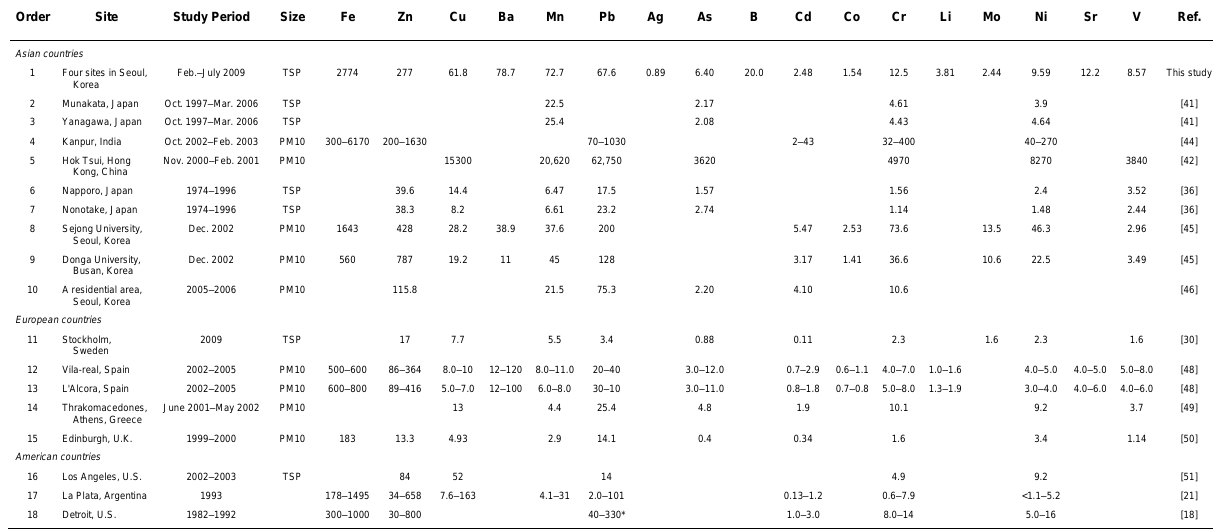
Comparison of the PM-Bound Metal Concentration Levels Measured in Urban Areas (Commercial and Residential Area) between the Present and the Previous Studies (All Units in ng m – 3